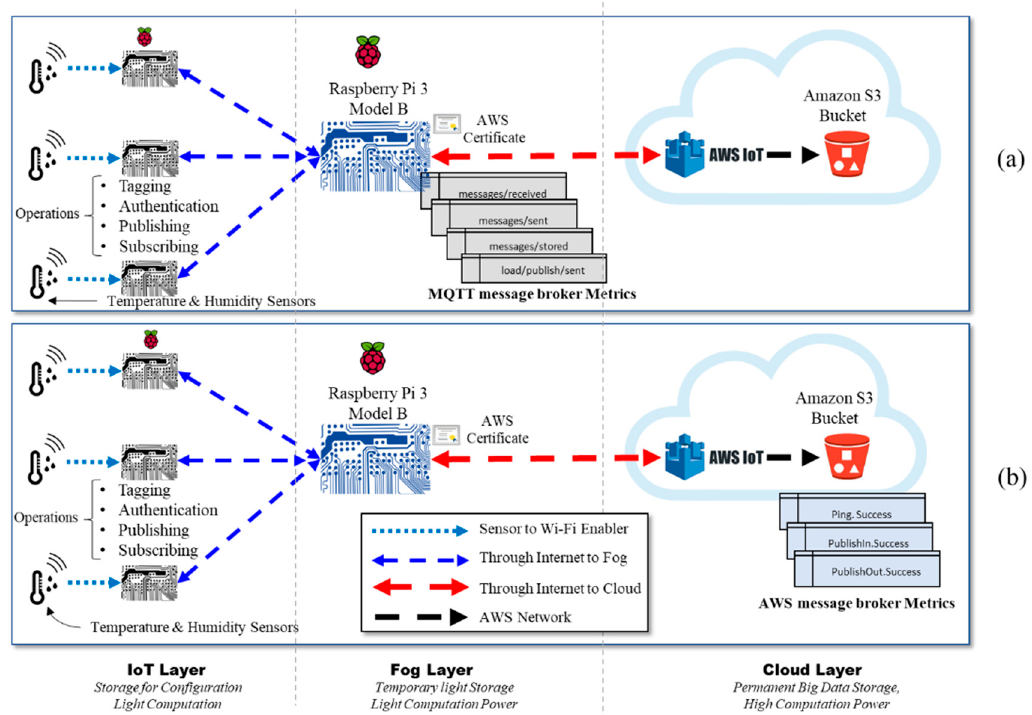
Figure 5. ( a ) Metrics applied in the fog layer vs. ( b ) metrics applied in the cloud layer.